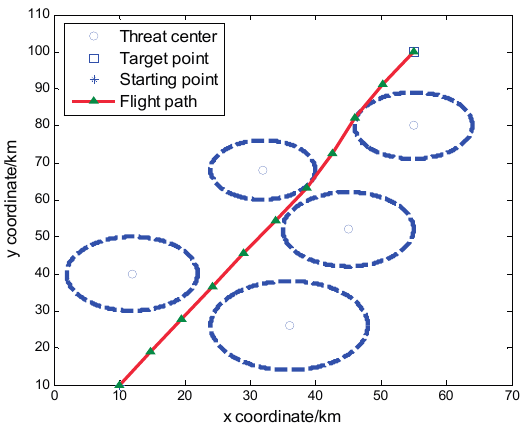
Figure 4. Result of the first instance for D = 10.